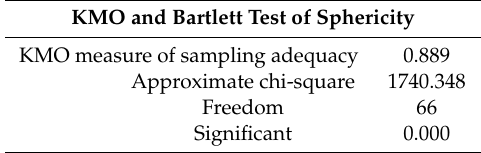
Table 4. KMO and Bartlett Test of Sphericity for the data of safety citizenship behaviour.